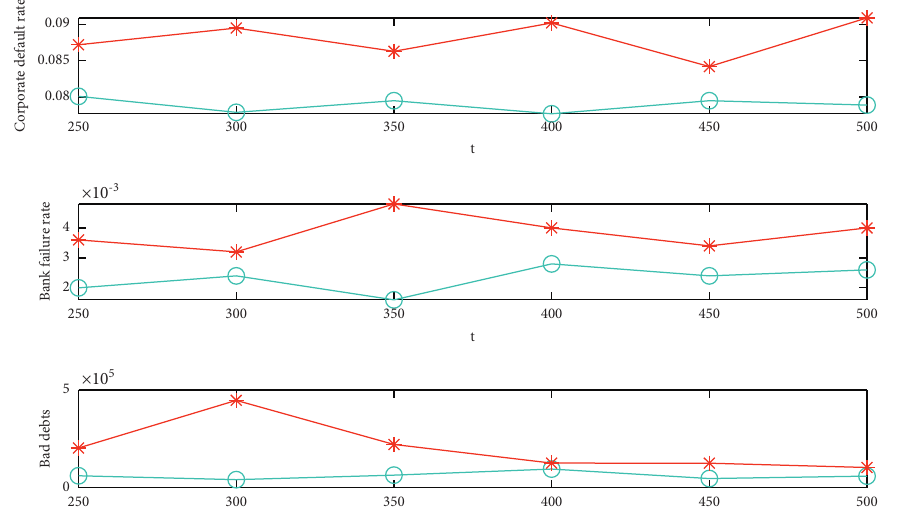
Figure 9: Evolution of risk contagion between banks and enterprises due to shocks to the largest banking entities in terms of